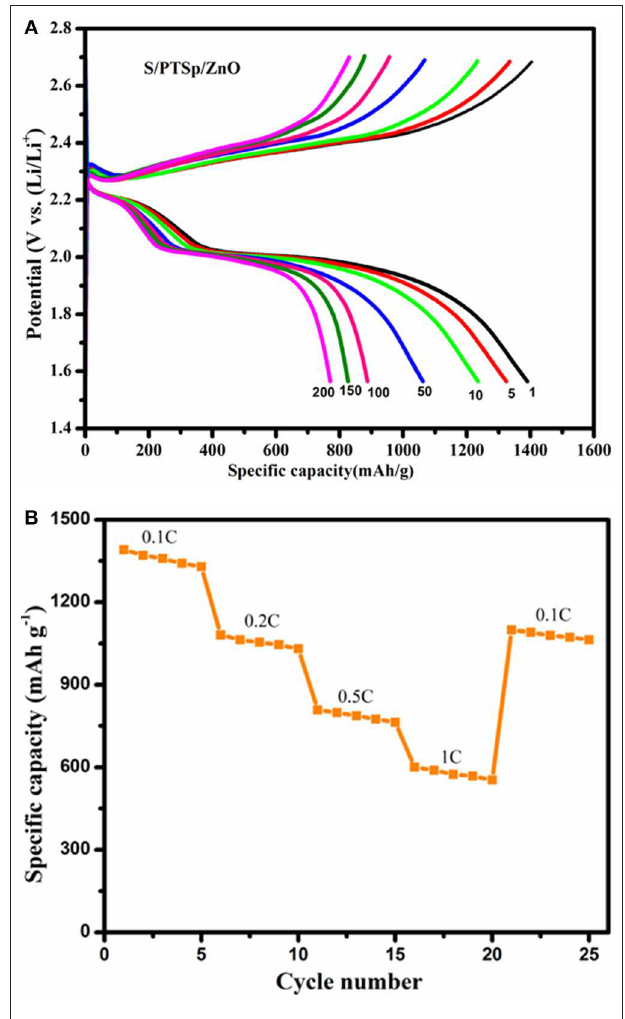
FIGURE 10 | (A) Galvanostatic charge-discharge curves of 1st, 5th, 10th, 50th, 100th, 150th, and 200th cycle of the S/PTSp/ZnO composite at a scan rate of 0.1C. (B) Rate performance of the